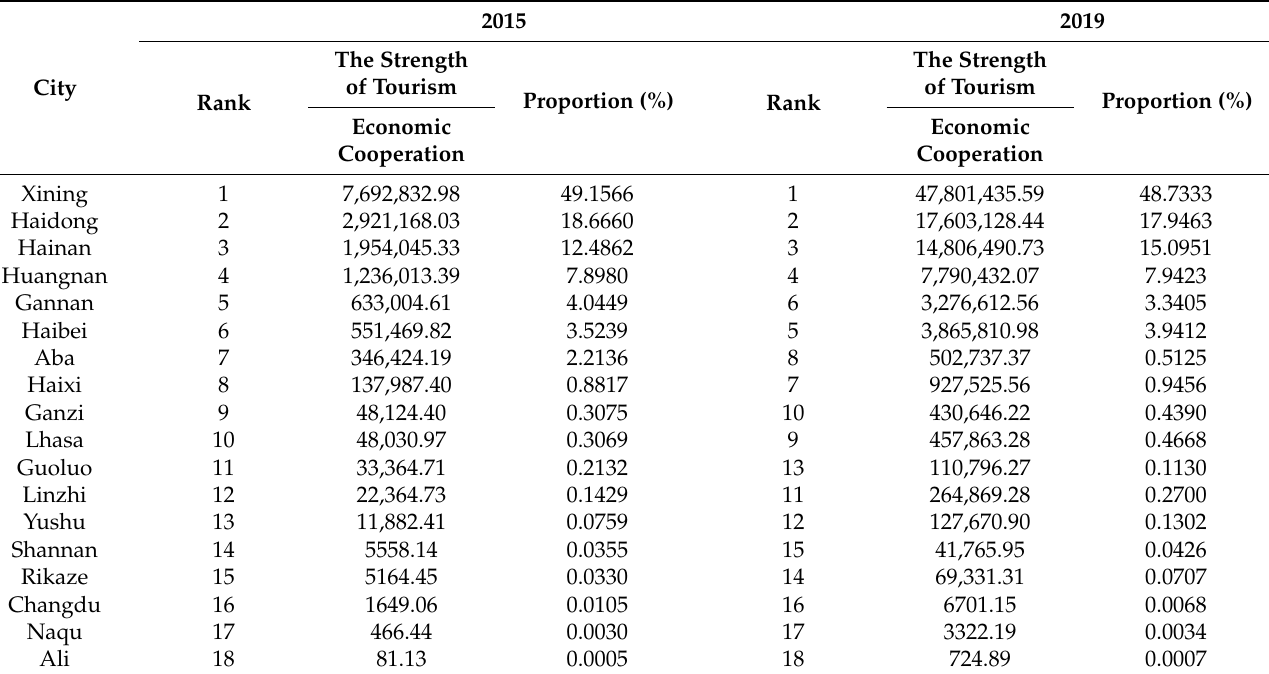
Table 2. The strength of tourism economic connections between